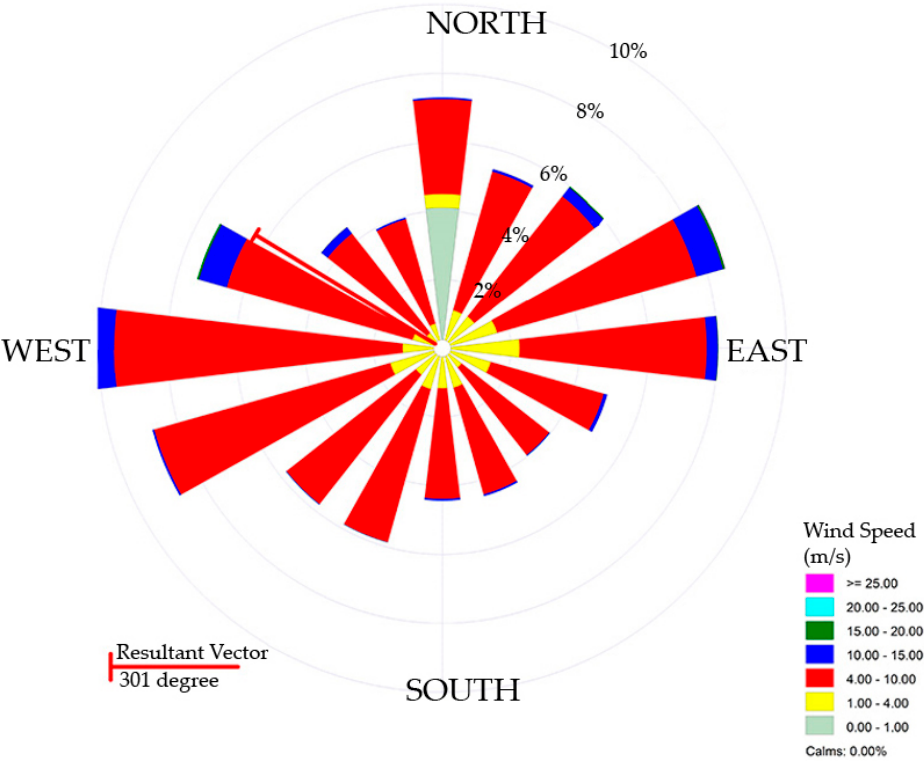
Figure 7. Windrose diagram of Siri Island station.